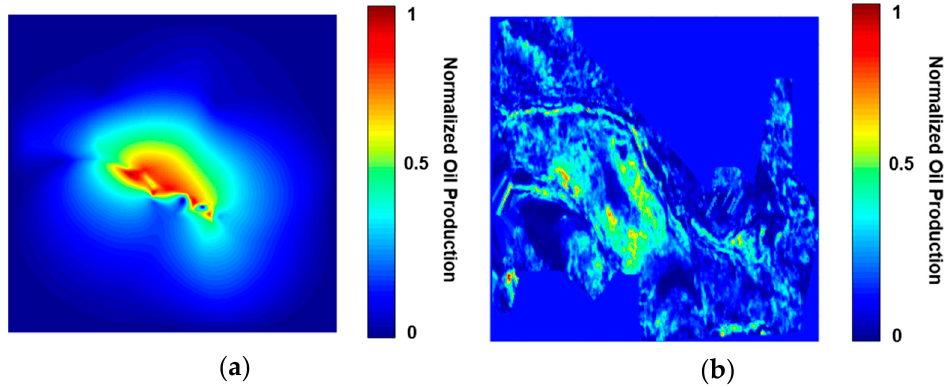
Figure 9. Oil production surface maps generated by Kriging ( a ) and the virtual intelligent system ( b ).